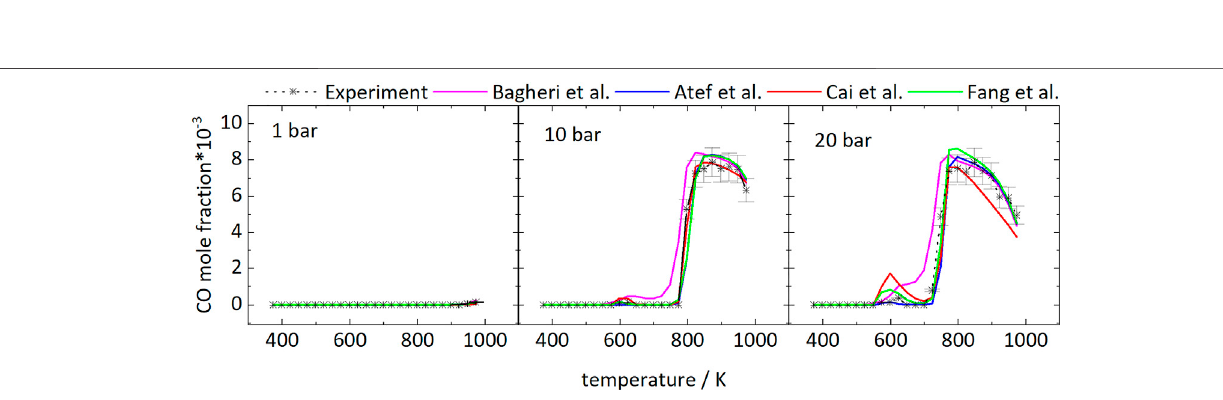
Figure 1 . Considering the experimental results, iso-octane